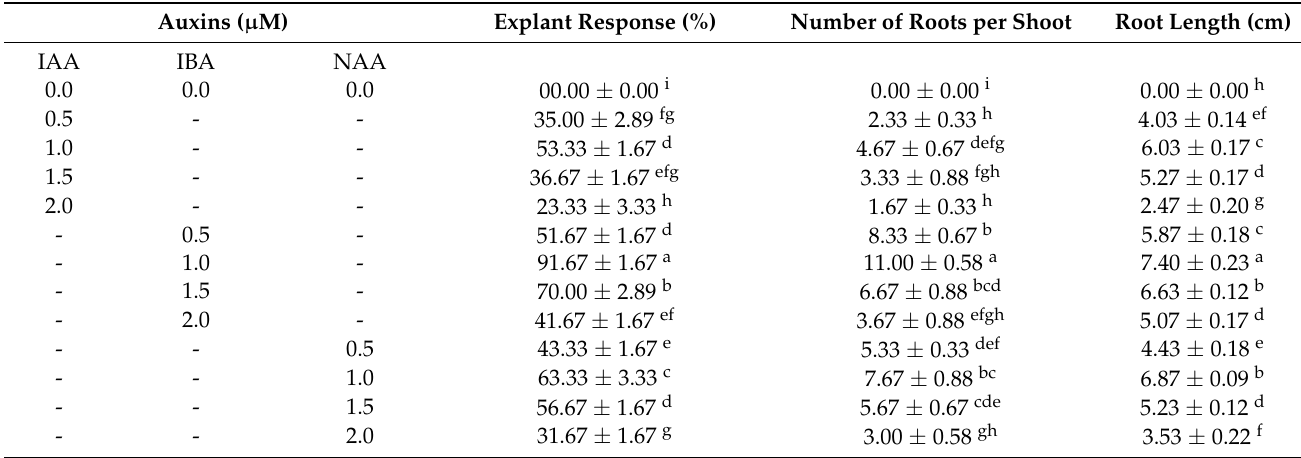
Table 3. Effect of various auxins on root induction in D. palmatus on phytagel solidified half-strength MS medium after four